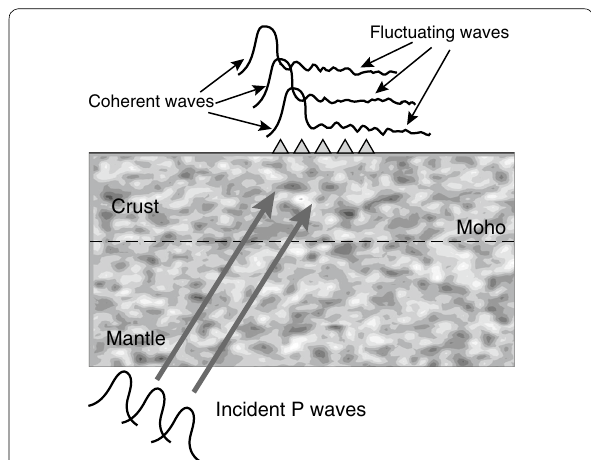
Fig. 1 A schematic illustration for the generation of teleseismic fluctuating waves. The incident primary P waves from teleseismic events are scattered off small-scale heterogeneities beneath the receivers during propagation through a random medium. The total waves recorded at the receivers consist of coherent and fluctuating